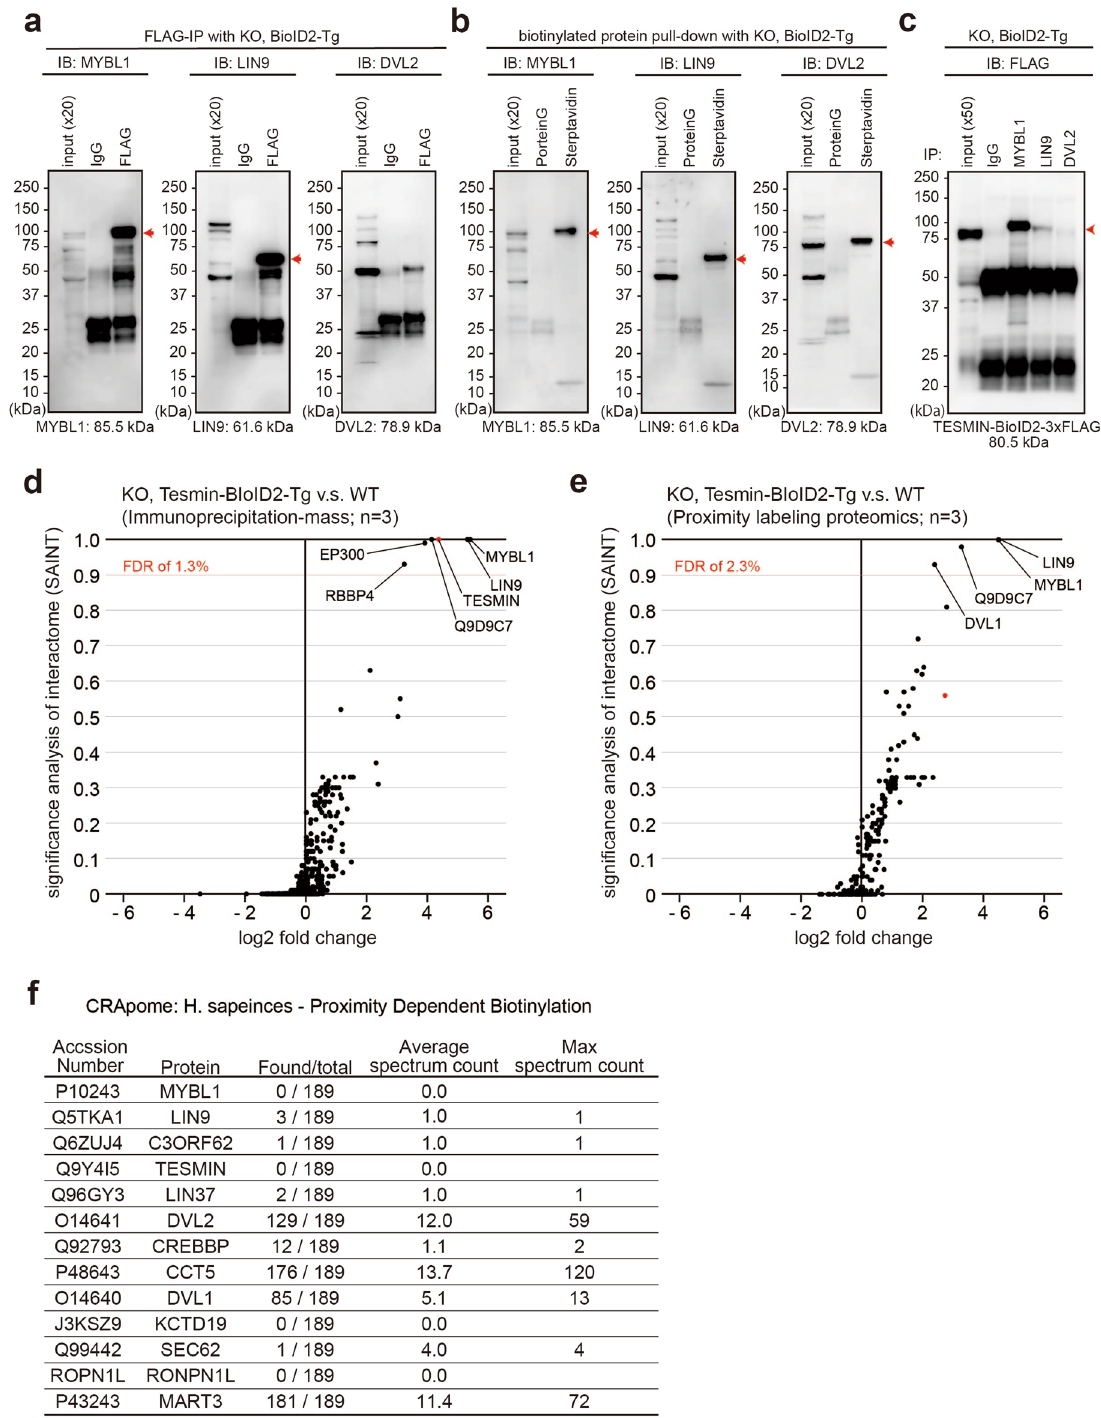
Figure 3. Immunoprecipitation and immunostaining of representative proteins. ( a , b ) Immunoblot analysis for MYBL1, LIN9, and DVL2 using eluted samples of IP ( a ) and proximity labeling proteomics ( b ). Red arrows indicate the expected protein size. ( c ) Immunoblot analysis for TESMIN-BioID2-3xFLAG using eluted samples of immunoprecipitation using anti-MYBL1, -LIN9, and -DVL2 antibodies. ( d , e ) Significance analysis of interactome (SAINT) and log2 fold change of average spectrum count are shown as scatterplots for immunoprecipitation-mass ( d ) and proximity labeling proteomics ( e ). The led dots indicate TESMIN. ( f ) The human orthologs of mouse proteins that were captured in proximity labeling proteomics using Tesmin-BioID2 transgenic mice (Fig. 2e). Human data were referred to because no mouse data are deposited. The found/total column shows the number of proximity labeling experiments that captured each protein in the contaminant repository for affinity purification (CRAPome)